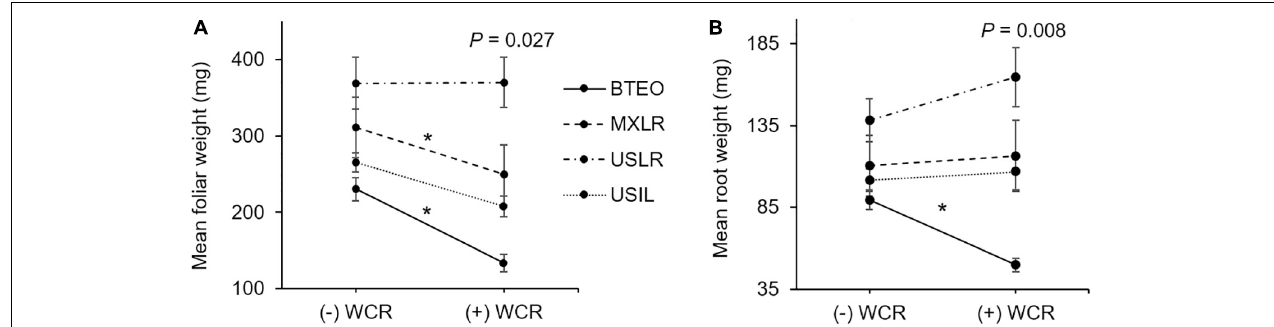
FIGURE 6 | (A) Above- and (B) belowground tissue losses in four plant types, Balsas teosintes (BTEO), Mexican maize landraces (MXLR), US maize landraces (USLR), and US inbred maize lines (USIL), exposed to root herbivory by Western corn rootworm (WCR) larvae. Inset in each plot are the univariate analysis of variance (ANOVA) statistics for the herbivory (+WCR, –WCR) × plant type effect in foliar weight ( F 3 , 167 = 3.126, P = 0.027) and root weight ( F 3 , 167 = 4.039, P = 0.008). Comparisons between plant types exposed (+WCR) and unexposed (–WCR) to Western corn rootworm larvae were made via a priori contrasts, with a critical P -value for each paired comparison set at P ≤ 0.012, per Sidak’s correction. Significant herbivory effects are indicated by an asterisk (*).